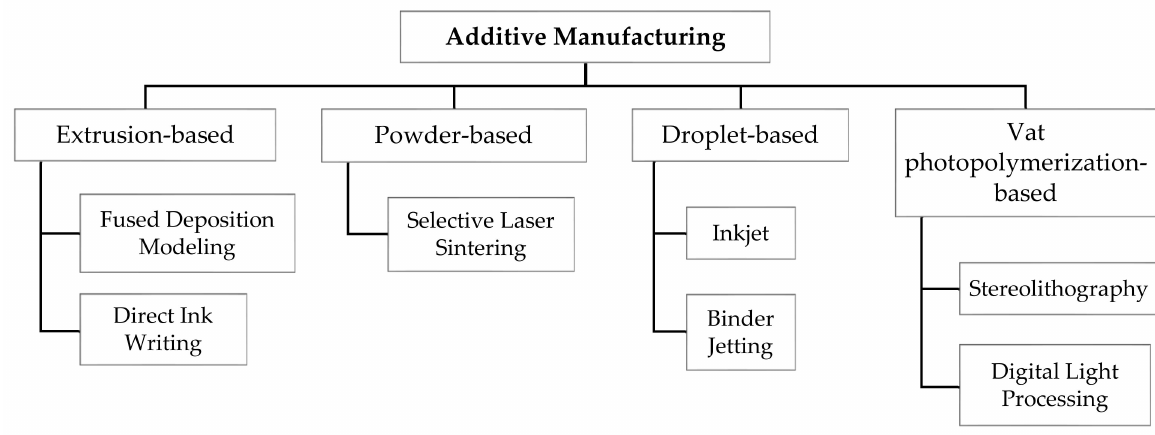
Figure 1. The additive manufacturing technologies used in oral tablet